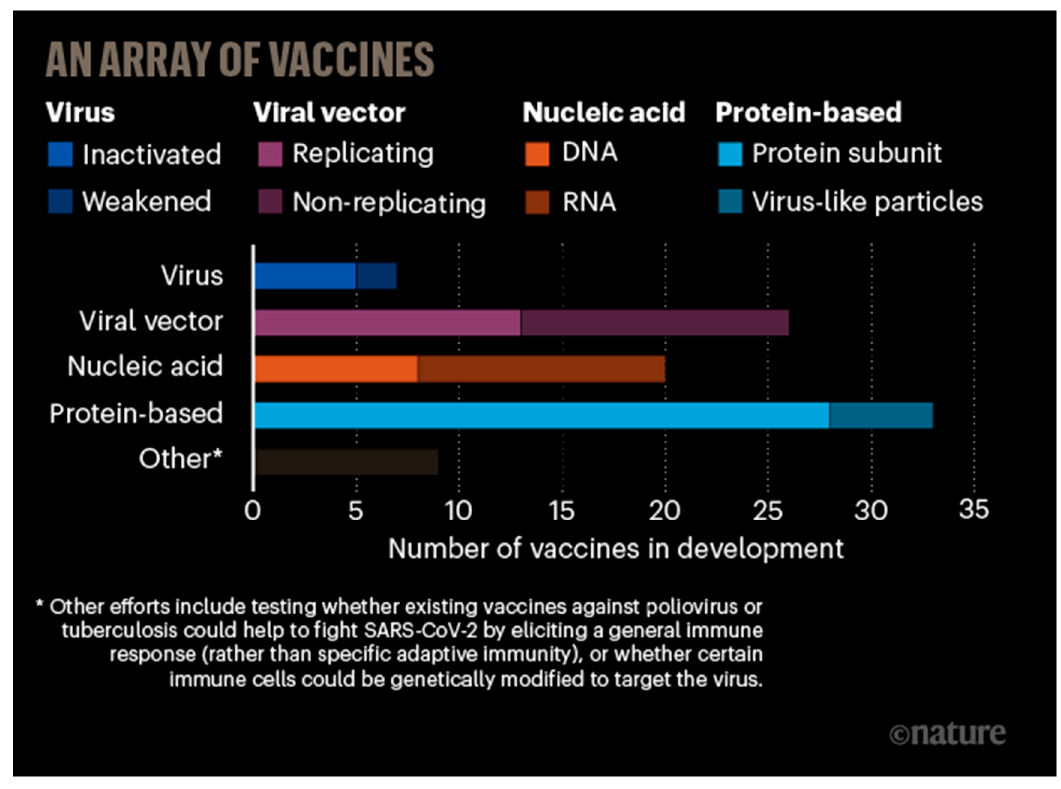
Figure 6. Eight types of explored vaccines against CoV, based on various viruses or viral parts. Redrawn from [73] . The details are obtained from WHO COVID-19 Vaccine Landscape and [74–76] .